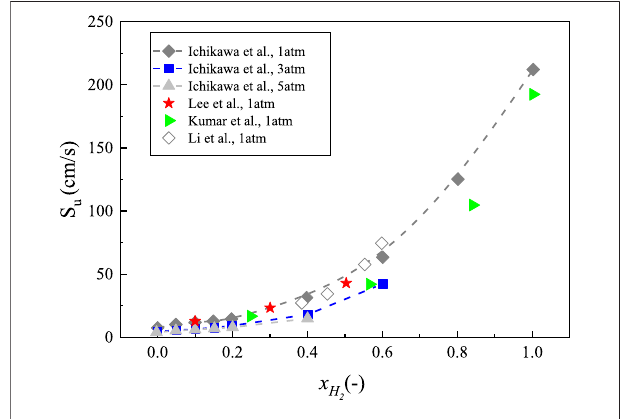
FIGURE 7 | Laminar burning velocity of NH 3 fl ame with a function of volumetric hydrogen fraction at 298 K,replottedfrom (Leeet al.,2010;Kumar and Meyer, 2013; Li et al., 2014; Ichikawa et al.,